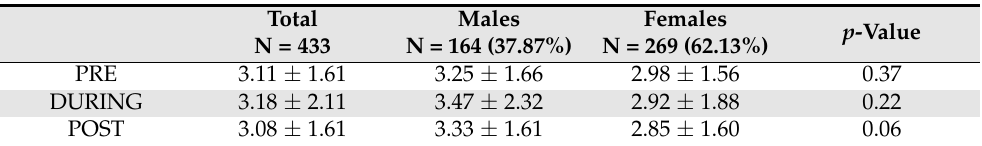
Table 7. Activity-exercise (days per week) of the study population. The comparison was performed with the use of Mann–Whitney U test.